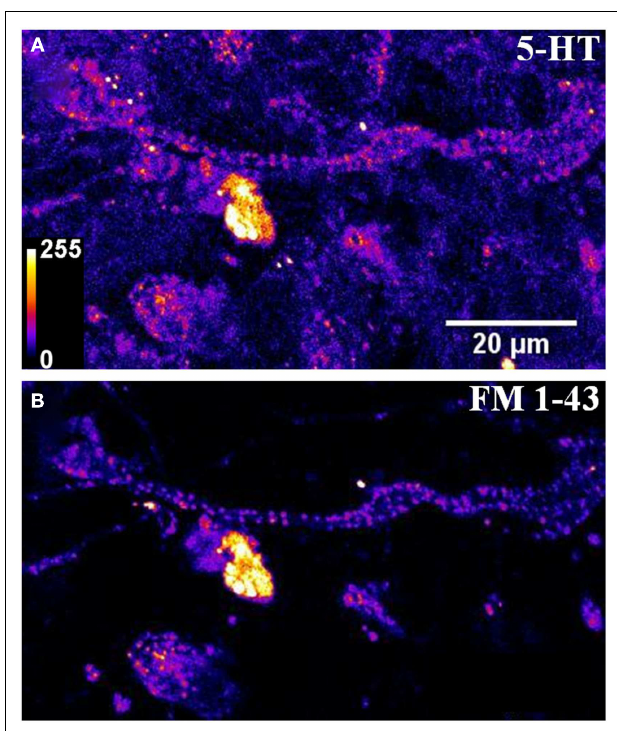
FIGUREA4 |A large area image of serotonergic cells shows a high degree of co-localization between (A) three photon image of serotonergic vesicular clusters and (B) confocal image of FM1-43 labeled spots. Most spots observed in the FM1-43 channel co-localize with bright spots observed in the serotonin channel, though there are entire cells in the serotonergic channel which do not appear to take up the dye FM 1-43 (Intensities false are color coded).